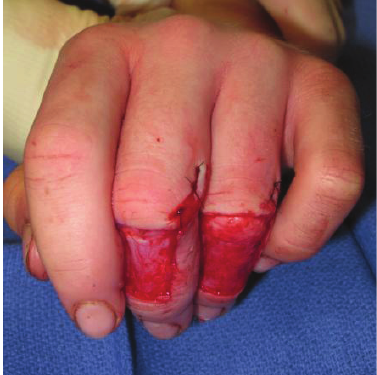
Figure 5. Donor site of the cross finger flaps prior to application of a full thickness skin